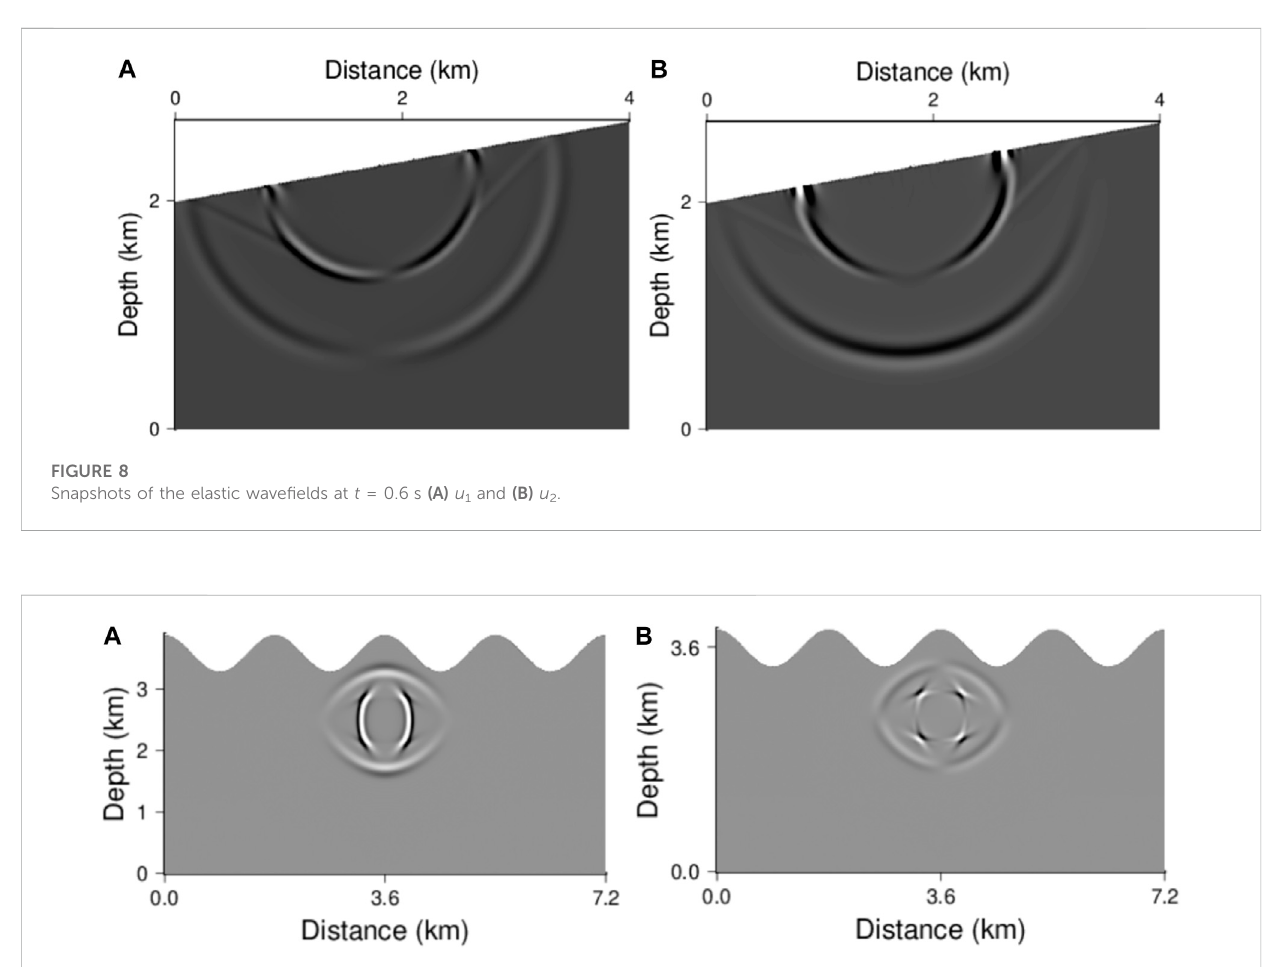
FIGURE 9 Snapshots of the elastic wave fi elds in anisotropic medium at t = 0.35 s (A) u 1 and (B) u 2